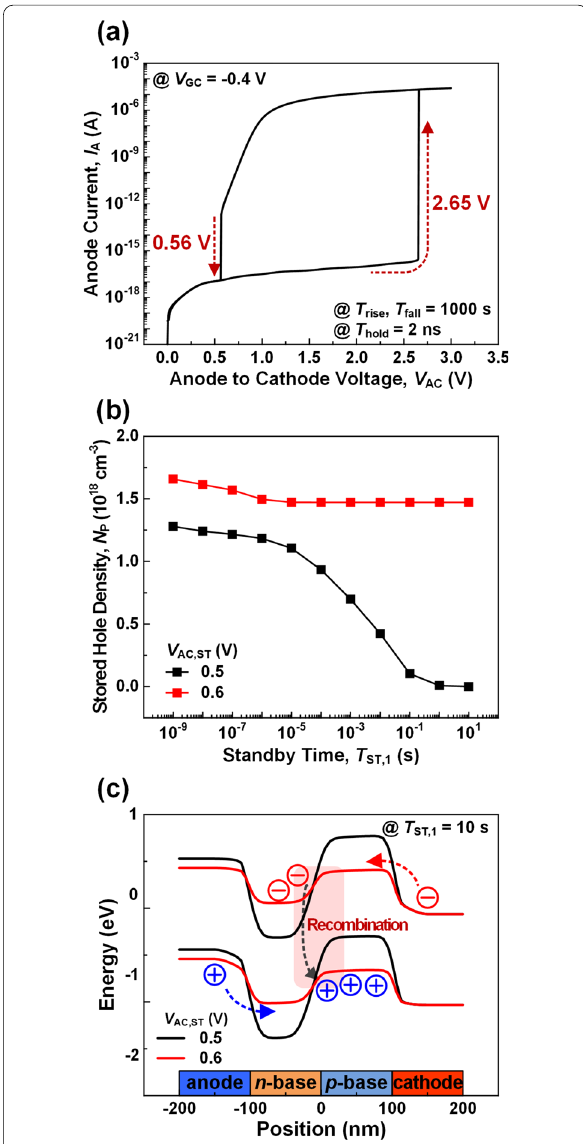
Fig. 4 a I A V AC characteristics of the 3‑T TRAM by the V AC pulse with − T rise , T fall 1000 s, T hold 2 ns when the V GC is fixed at 0.4 V. b N P as = = − a function of T ST,1 at different V AC,ST of 0.5 V (black line) and 0.6 V (red line). c Energy band diagrams at T ST,1 10 s with different V AC,ST of = 0.5 V and 0.6 V